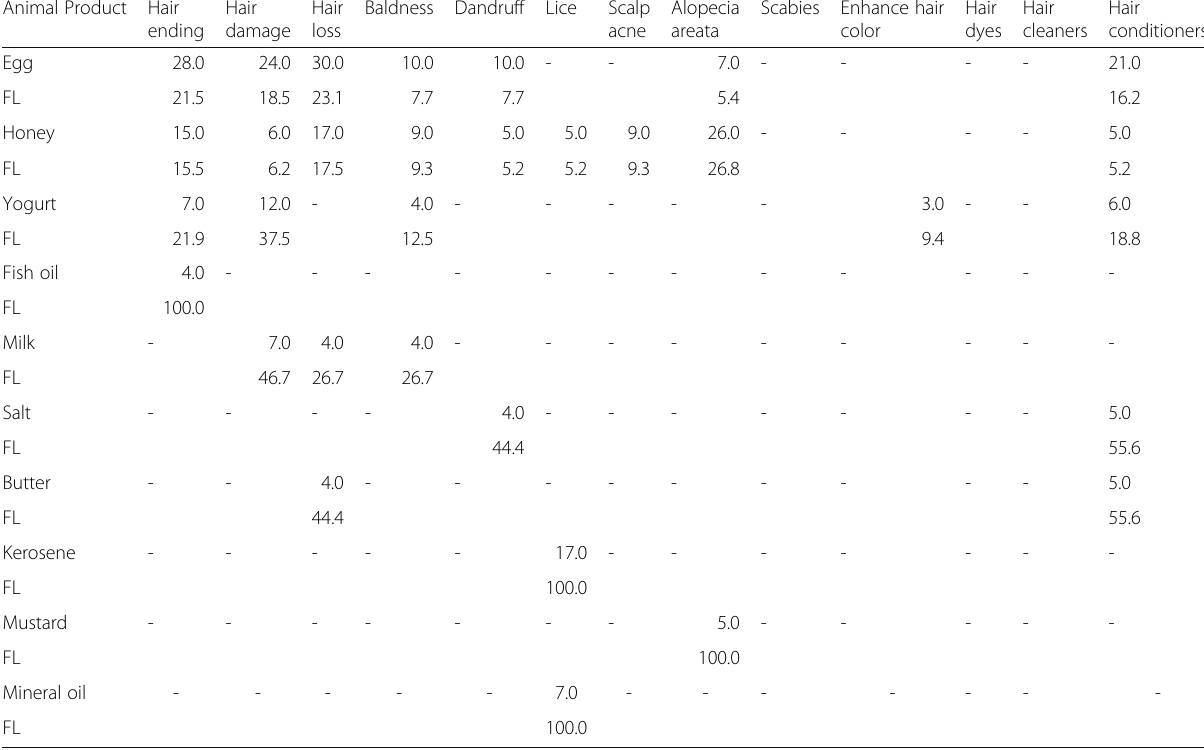
Table 5 Fidelity level of other natural products used in the treatment of hair and scalp in the West